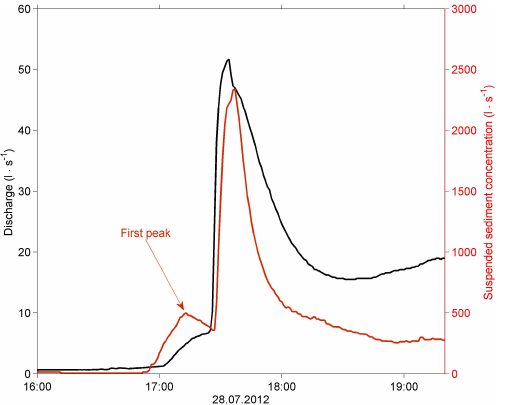
Fig. 2. HOAL catchment with point of flood initiation (590) and measurement sites (360, 160,